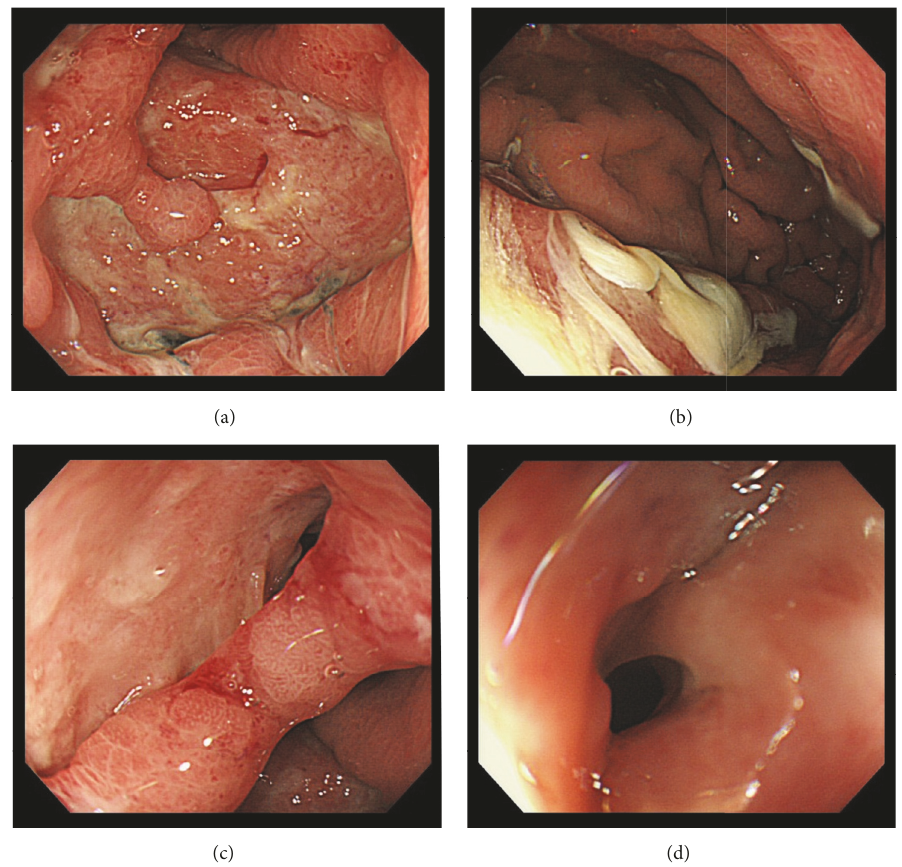
Figure 3: Upper endoscopy (day 29 post-ESD), (a) ulcer, (b) yellow mucus, and (c, d) ulcer and false